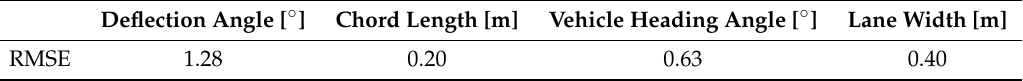
Table 3. Laser-camera root-mean-square error (RMSE)